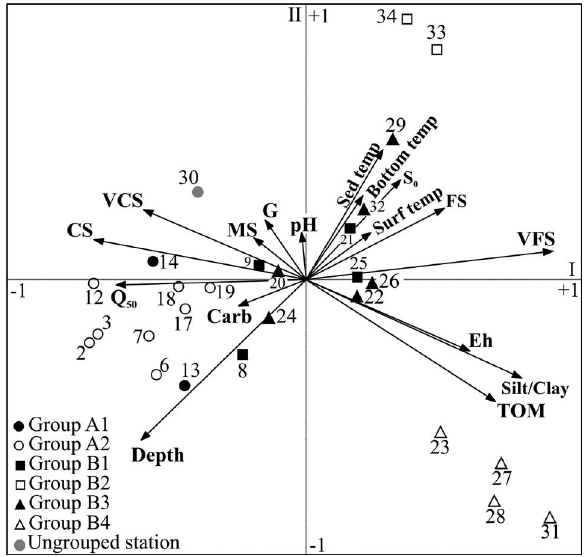
Fig . 4. – Canonical correspondence analysis (CCA) ordination of stations and environmental variables relative to axes I and II for the Ría de Aldán. Gravel, G; very coarse sand, VCS; coarse sand, CS; medium sand, MS; fine sand, FS; very fine sand, VFS; median grain size, Q ; sorting coefficient, S ; bottom temperature, Bottom temp; 50 0 sea surface temperature, Surf temp; sediment temperature, Sed temp; carbonate content, Carb; total organic matter content,